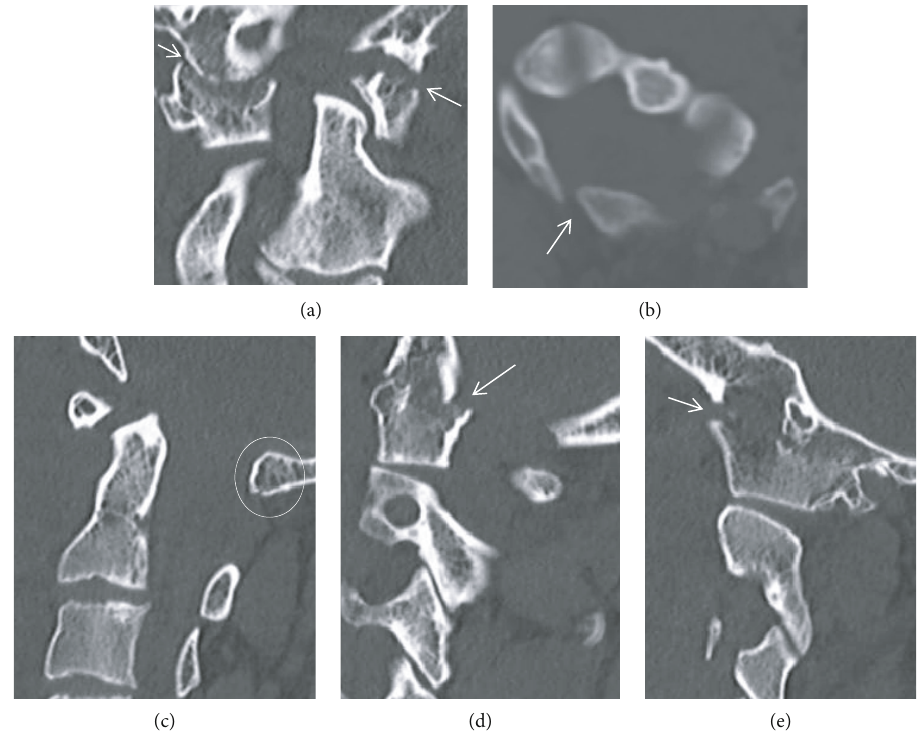
Figure 4: Case 2: cervical CT. C1 congenital partial assimilation to the skull base. (a) The right C1 lateral mass is partially fused with the right occipital condyle. The left C1 lateral mass is completely fused to the left condyle. The tip of the dens is dysplastic and asymmetrically positioned towards the left lateral mass. (b) The rachischisis of the C1 posterior arch. (d, e) Acute fracture dislocation of the previously right and left lateral mass assimilation,